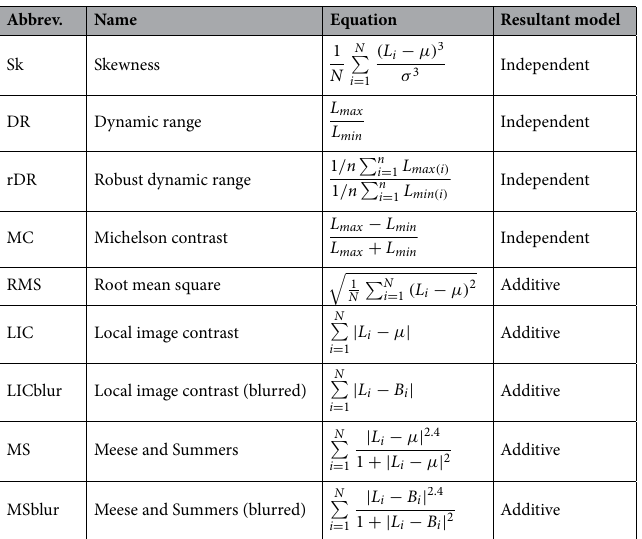
Table 1. Table summarising the global contrast estimators used in modeling conjoint measurement assessment of metallicity. N denotes the total sample number (i.e. the number of pixels in the image), while n denotes the number of a sub-population. B is a highly blurred copy of the original luminance image, L . µ is the mean luminance value and σ is the standard deviation of the luminance